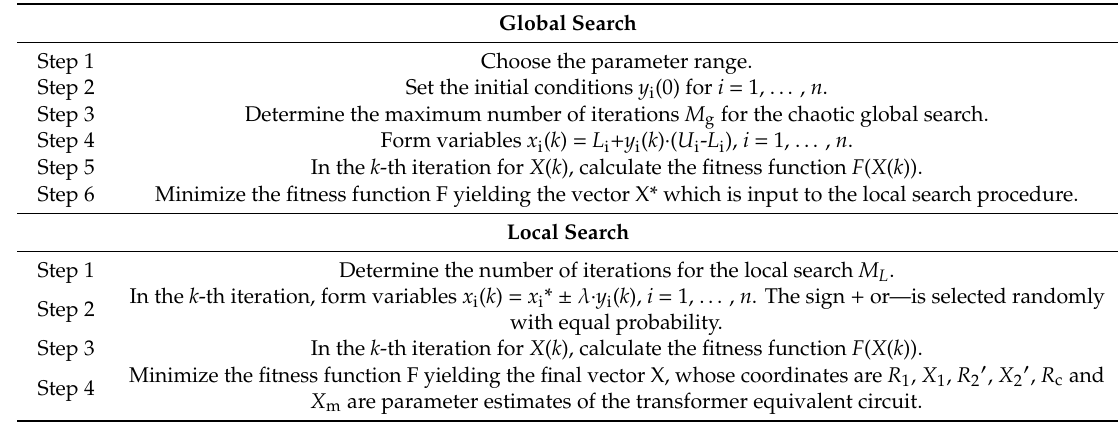
Table 1. Chaotic Table 1. Chaotic search.